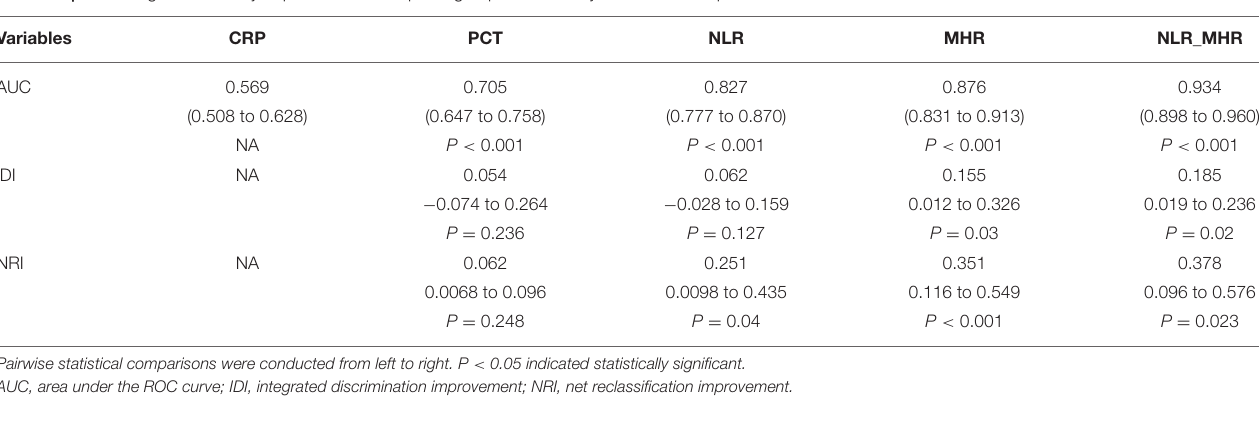
when microbial molecular patterns are identified by specific receptors expressed on immune cells (32). This interaction can activate immune cells, including neutrophils and lymphocytes, to release both proinflammatory and anti-inflammatory